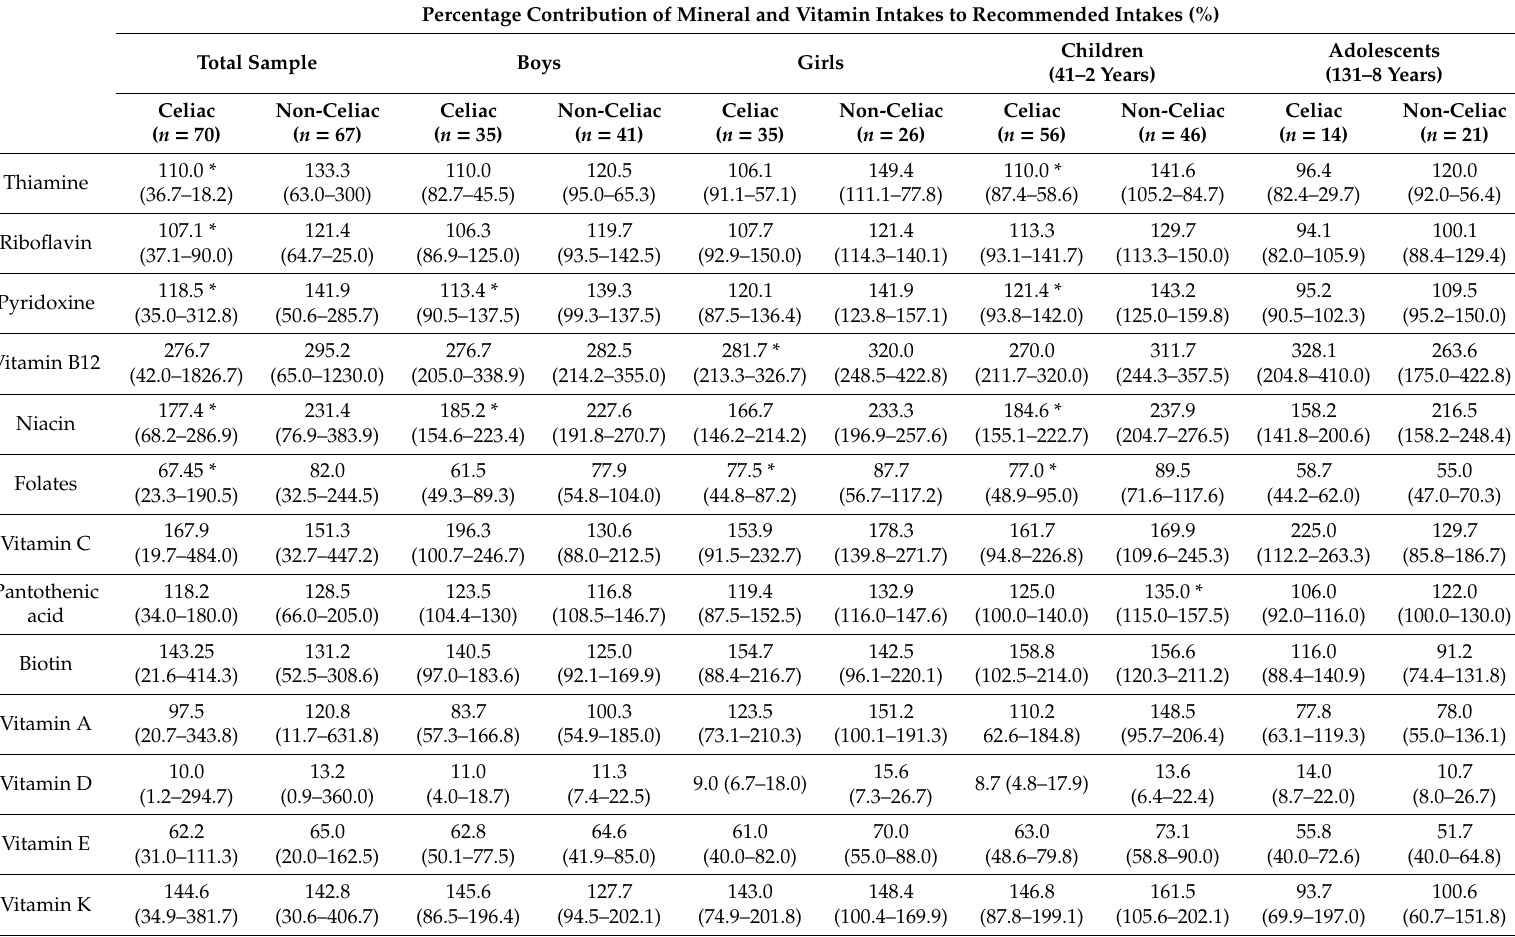
Table 7. Adequacy of vitamin intake in the diet of celiac and non-celiac children and